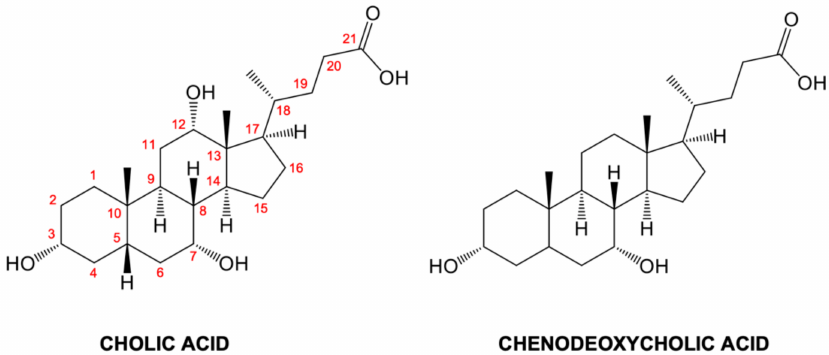
Figure 1. Chemical structures of cholic acid (CA) and chenodeoxycholic acid (CDCA). The CA atom numbering is